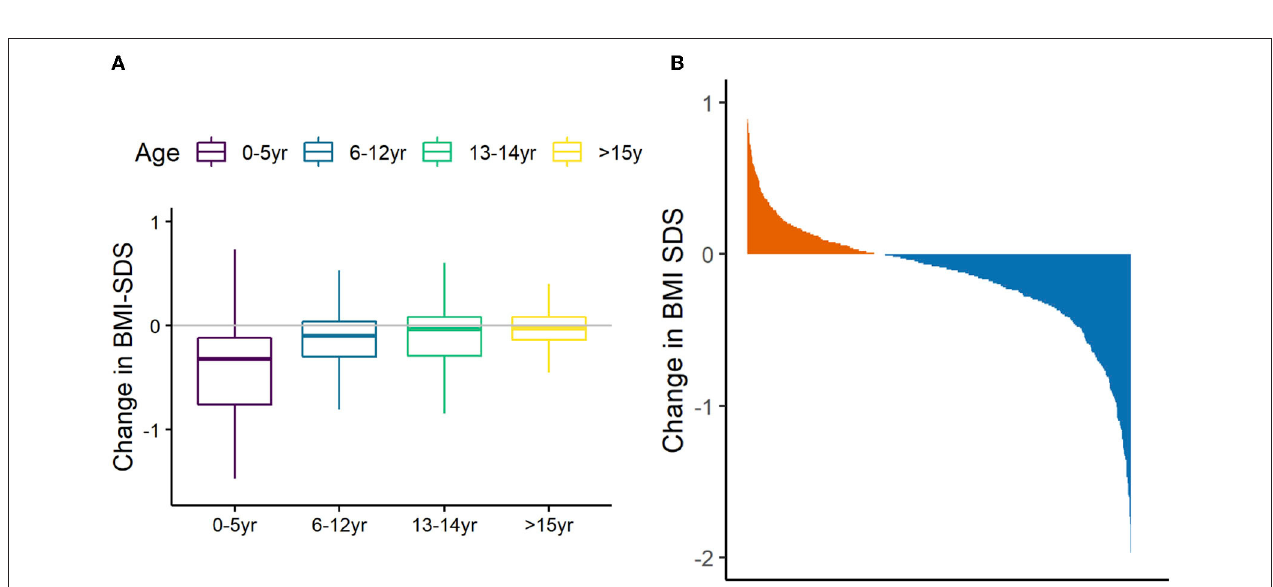
FIGURE 2 | Proportion of children presenting to W82GO by Pobal Deprivation Score category illustrating that although the most common category was “Marginally above Average”, the data are strongly skewed toward disadvantage.